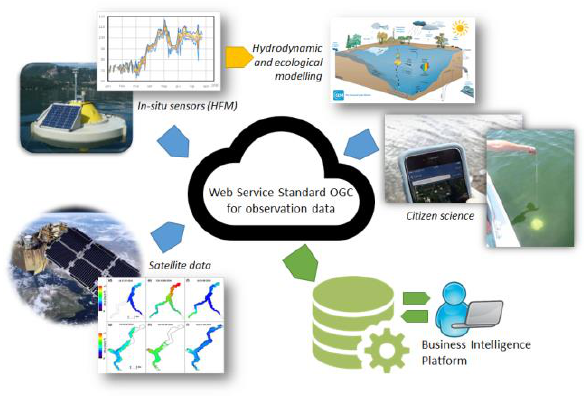
Figure 2. Scheme of the SIMILE